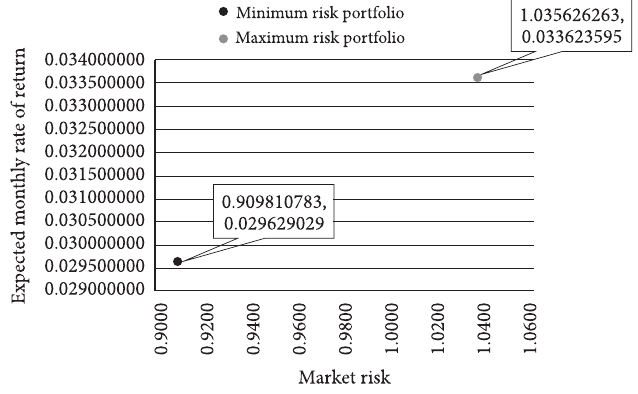
Figure 4. Positive risk-return relationship (the sample size is 50; weight constraint is 0.05; the interval is